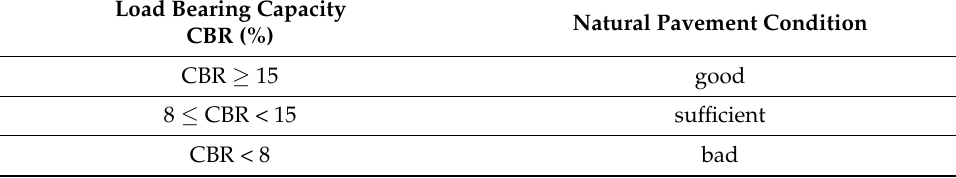
Table 4. Assessment criteria of the load bearing capacity for the natural AFE at a depth of 0.50 m up to 0.85 m (layer